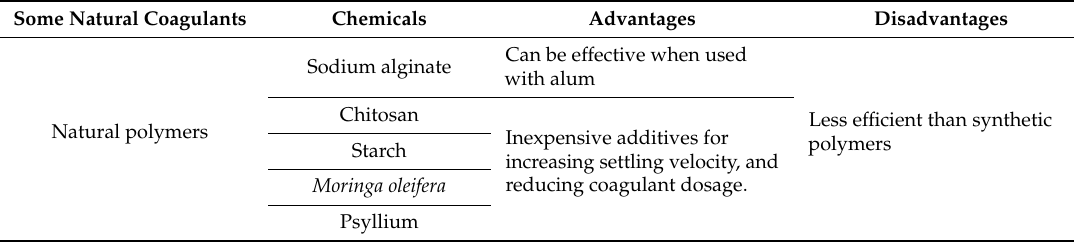
Table 15. Natural coagulants advantages and